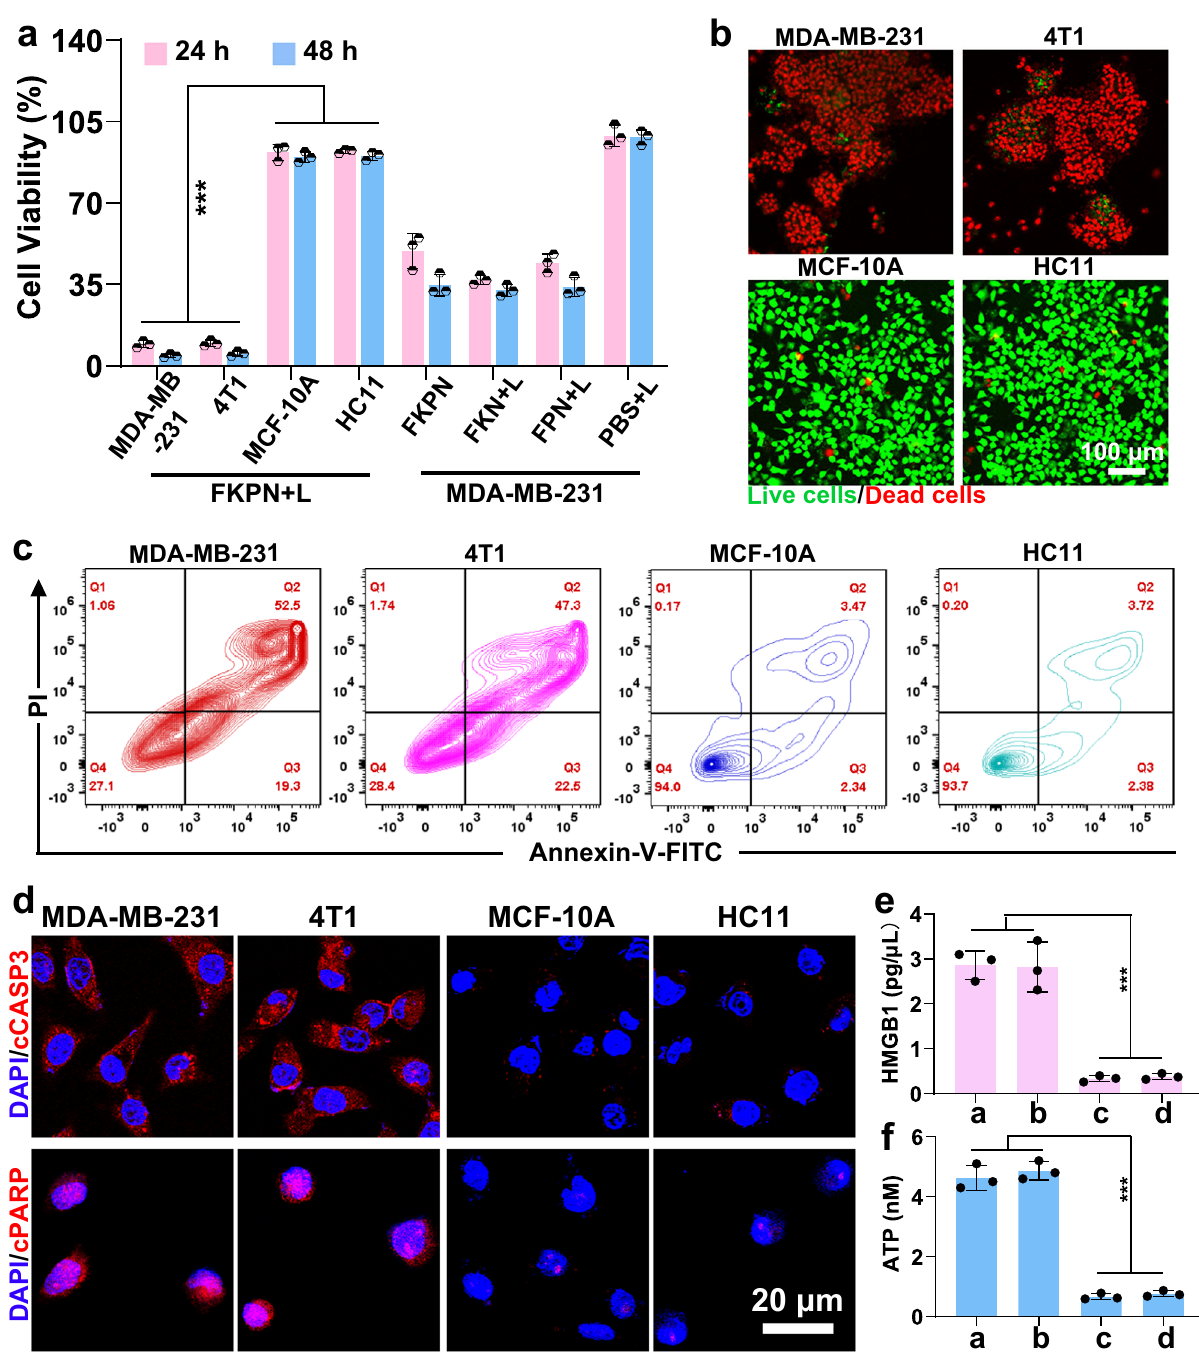
Fig.4|FKPNcombinedwithlaserirradiationinducesICDofcancercells.a CCK- 8 assay of cancer and non-cancer cell viability after culture with FKPN for various times and treated with laser irradiation. Data were presented as mean±SD ( n =3 independent experiments). P values: 2.34443E-07. b CLSM images of live/dead staining of treated cells. c Flow cytometry analysis of the apoptosis of cancer and non-cancer cells after treatment with FKPN plus laser irradiation. d Apoptosis pathway analysis of treated cancer and non-cancer cells assessed by immuno- fl uorescence staining of cCASP3, and cPARP. e Quanti fi cation of released HMGB1